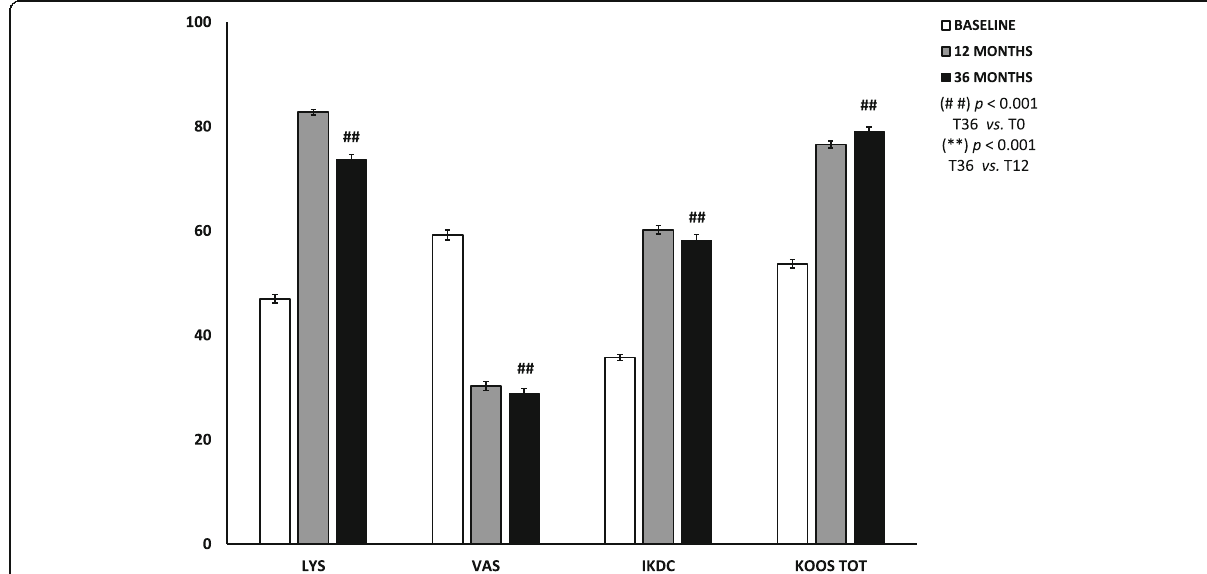
Fig. 1 Trend of functional improvements of Tegner Lysholm knee, VAS pain, IKDC subjective and total KOOS pre-operatively (white bars), at 12 (grey bars) and 36 months (black bars) after micro-fragmented adipose tissue injection. Results are expressed as mean and standard